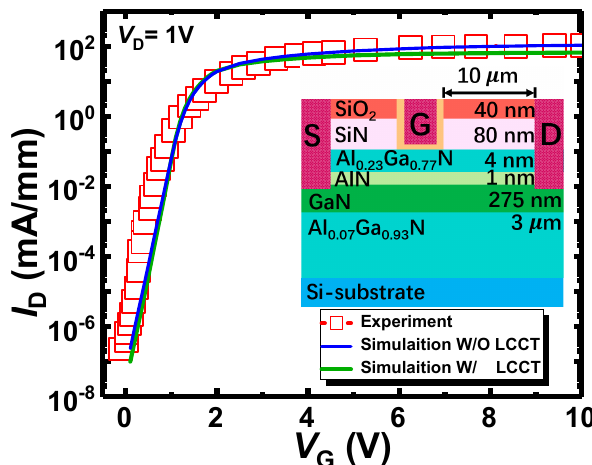
Figure 5. The calibration of the simulator with the experiments (inset figure is the structure used in the calibration).